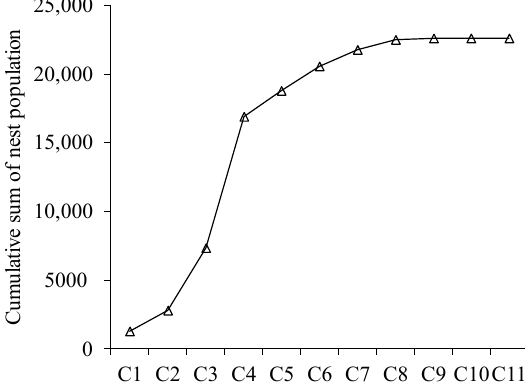
Figure 4. The cumulative sum of the mean population for each comb in secondary nests. From comb 1 (C1) to comb 11 (C11).